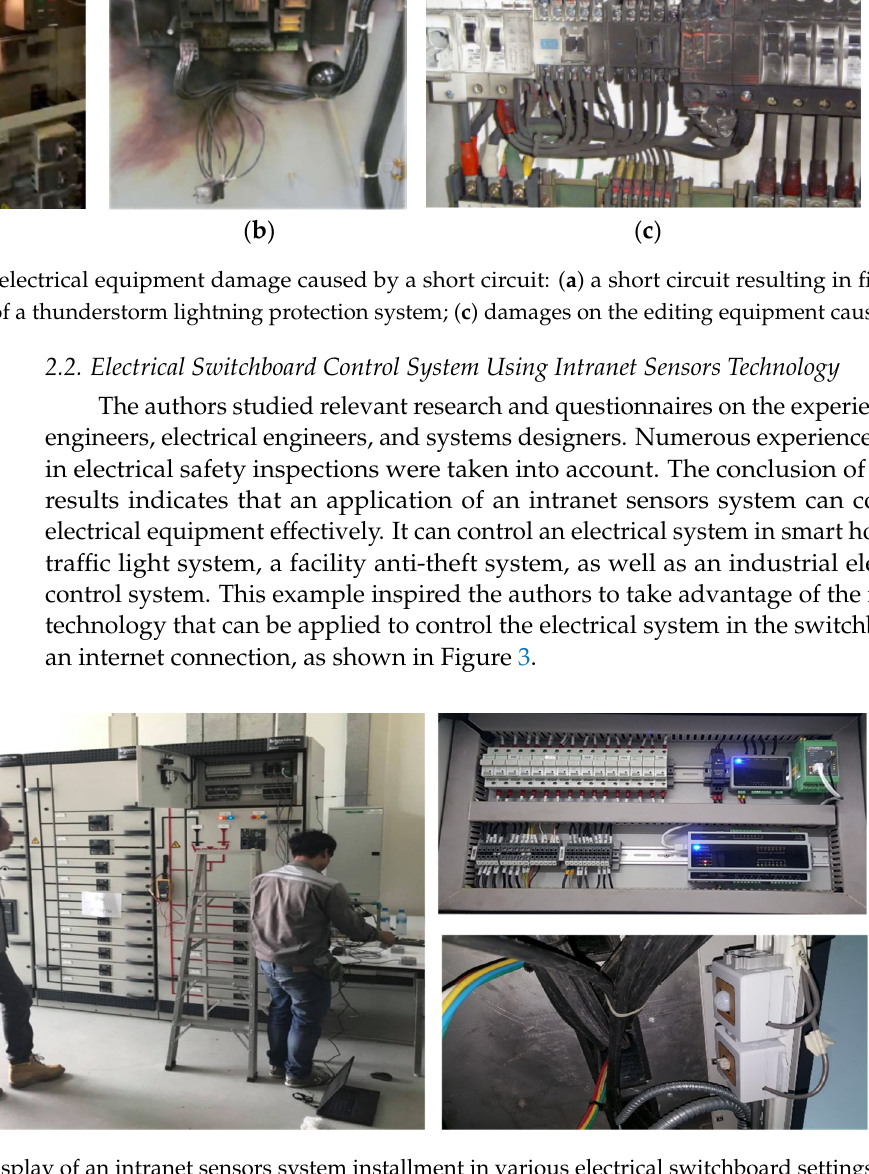
Figure 1. A display of status checks on electrical system: ( a ) heat checked by inspectors; ( b ) thermal- imaging sensor technology temperature check; ( c ) display of the thermal temperature results, with green areas indicating low-temperature area and red areas indicating high temperature.